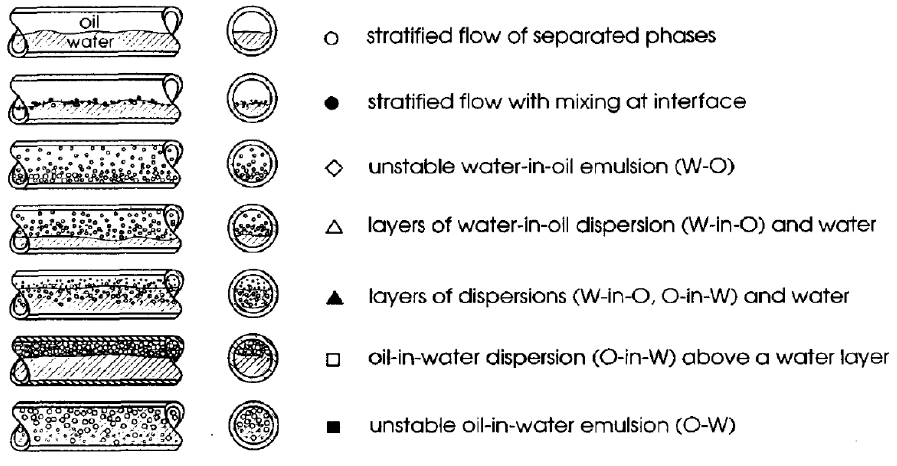
Figure 3. Typical horizontal oil-water flow pattern sketches modified after Trallero et al. [11].